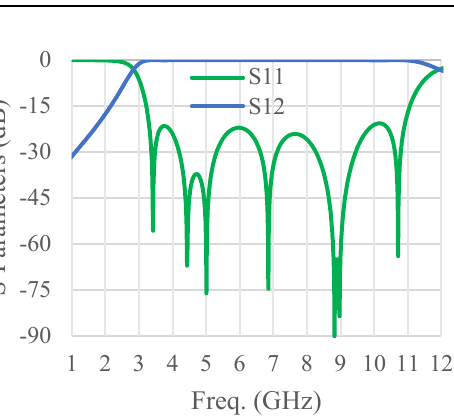
Figure 7. UWB filter with LC equivalent resonators.